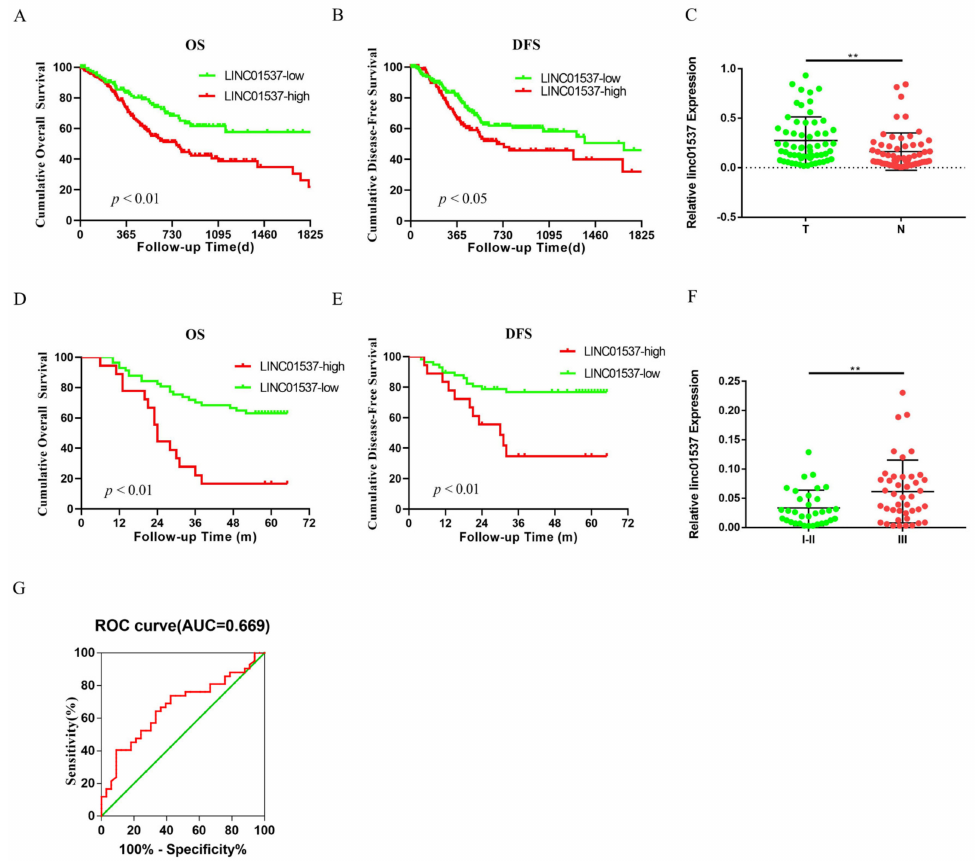
Figure 1. High expression of LINC01537 is associated with poor diagnosis in GC. OS ( A ) and DFS ( B ) were compared between LINC01537 high and low expressions in GC patients from the TCGA cohort (Kaplan-Meier survival analysis, N = 334). ( C ) Expression levels were compared between 59 GC and adjacent normal tissues (Student’s t -test, N = 59). OS ( D ) and DFS ( E ) were compared between LINC01537 high and low expressions in GC patients in our hospital (Kaplan-Meier survival analysis, N = 75; LINC01537-high, N = 18; LINC01537-low, N = 57). ( F ) Expression levels of LINC01537 were compared between stage I–II and stage III patients. ( G ) ROC curves were used to evaluate the role of LINC01537 in predicting the TNM stage of GC. The survival difference was determined using Kaplan-Meier analysis and log-rank test ( A,B , D , E ). Student’s t -tests ( C , F ) were employed to analyze the statistical differences. ** p < 0.01, m: